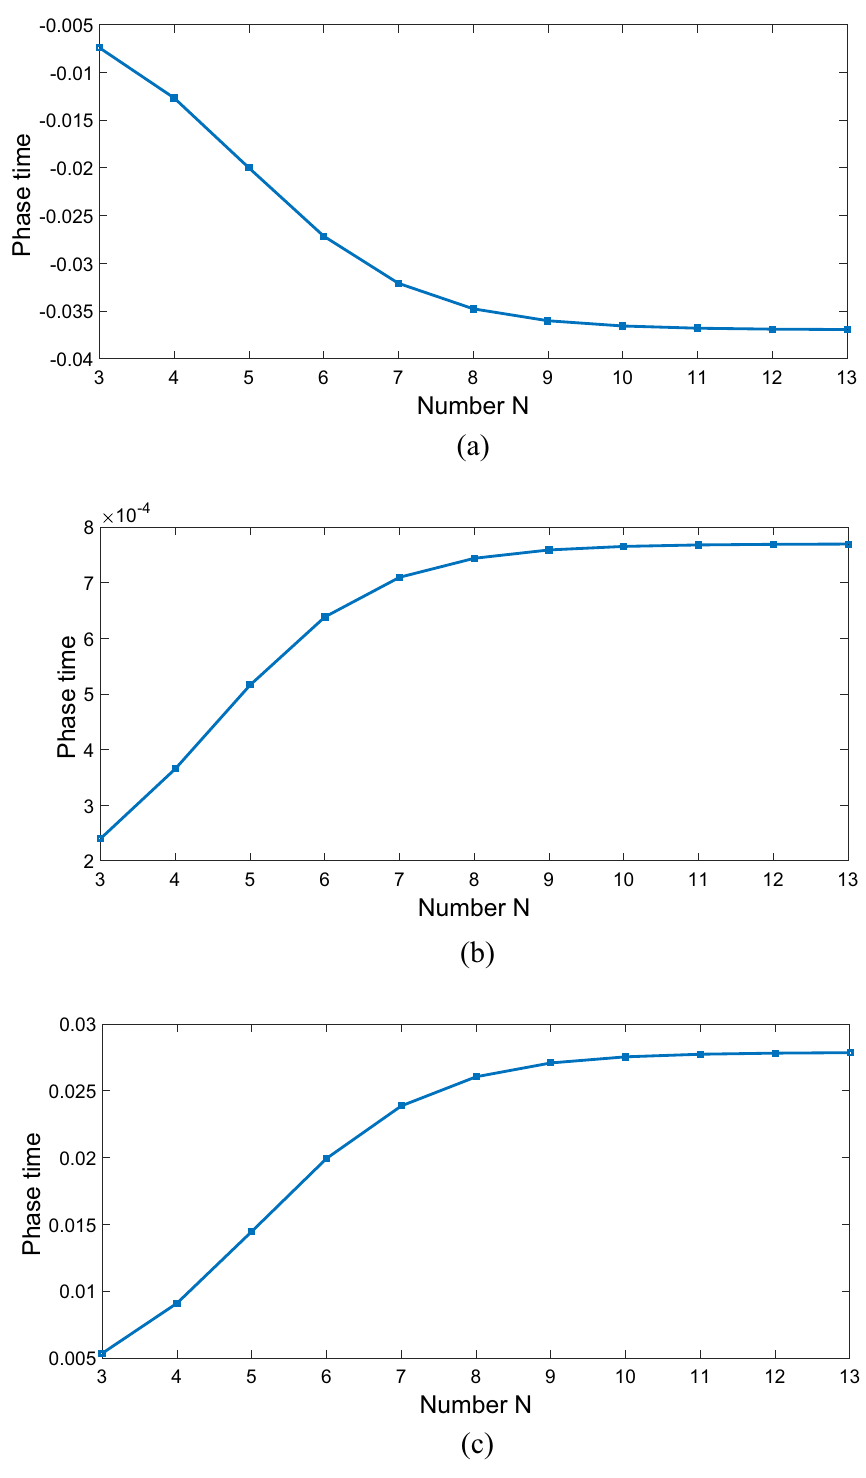
Figure 2. The Hartman effect in a 1DPC’s with structure ( AB ) 2 ADA ( BA ) N for ( a ) � c = 0.6 γ , � d = 0.9 γ , �ϕ = 0 , ( b ) � c = 0.6 γ , � d = 5 γ , �ϕ = 0 , ( c ) � c = 0.6 γ , � d = 0.9 γ , and �ϕ = π existence of QD defect layer. Other parameters are γ 21 = γ 31 = γ 32 = γ = 1 mev, Ŵ 21 = Ŵ 31 = Ŵ 32 = 5 γ , � p = 0.2 γ , and (cid:31) d =